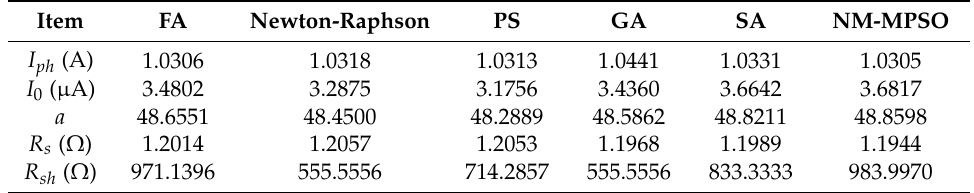
Table 12. Optimal parameter values identified by FA for Photowatt-PWP 201 polycrystalline photovoltaic module single diode compared with other methods.